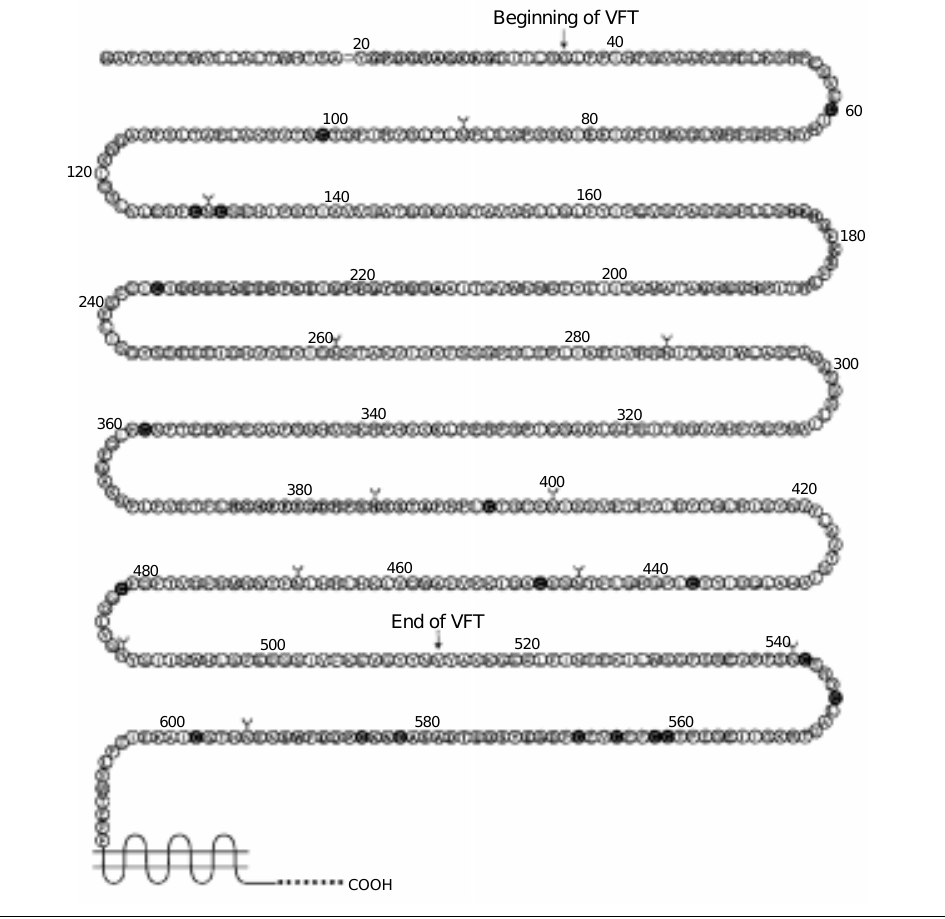
Figure 1. Schematic diagram of the human extracellular calcium-sensing receptor (hCaR) showing the amino acid sequence of the large hCaR extracellular domain. The location of the N-linked glycosylation sites is shown and all the 19 cysteines are shown inside black circles. The beginning and the end of the putative “venus flytrap” (VFT) domain are indicated. The cysteine-rich domain includes the nine cysteine residues located between C542 and